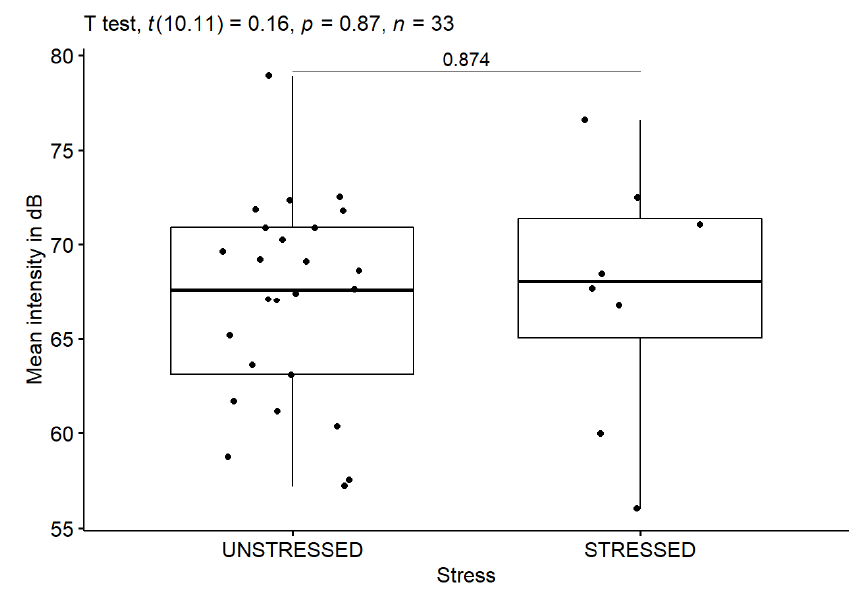
Figure 5. Boxplot for Mean intensity grouped by stress.